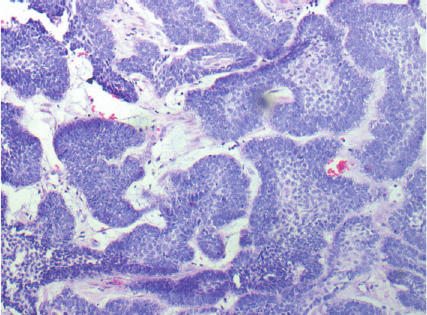
Figure 6: Photomicrograph shows island of uniform baseloid cells in a mature fibrous connective tissue